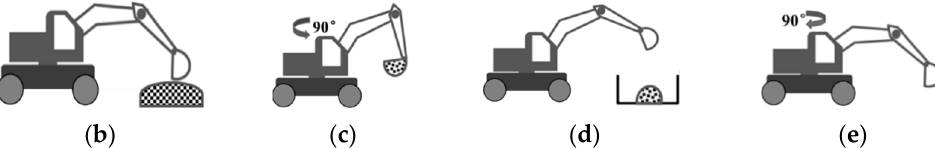
Figure 1. Excavator work system.